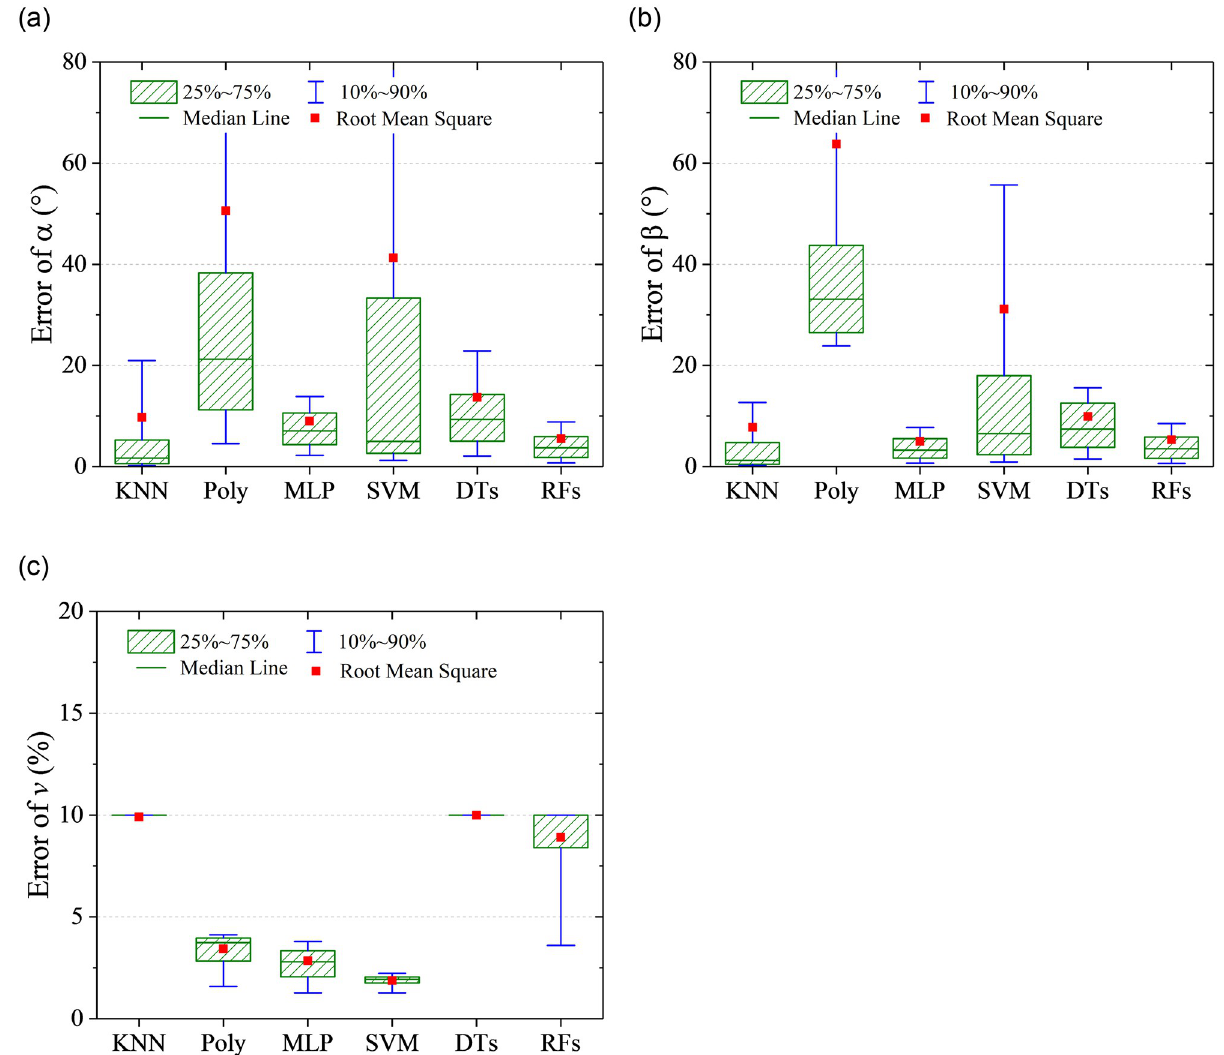
Fig 22. Quantile statistics on the prediction errors. (a) angle of attack, α (b) sideslip angle, β (c) flow velocity, v . Figs 23 and 24 present the error distributions with SVM and RFs algorithm. Only the pre- dicted flow velocity by SVM is satisfactory.